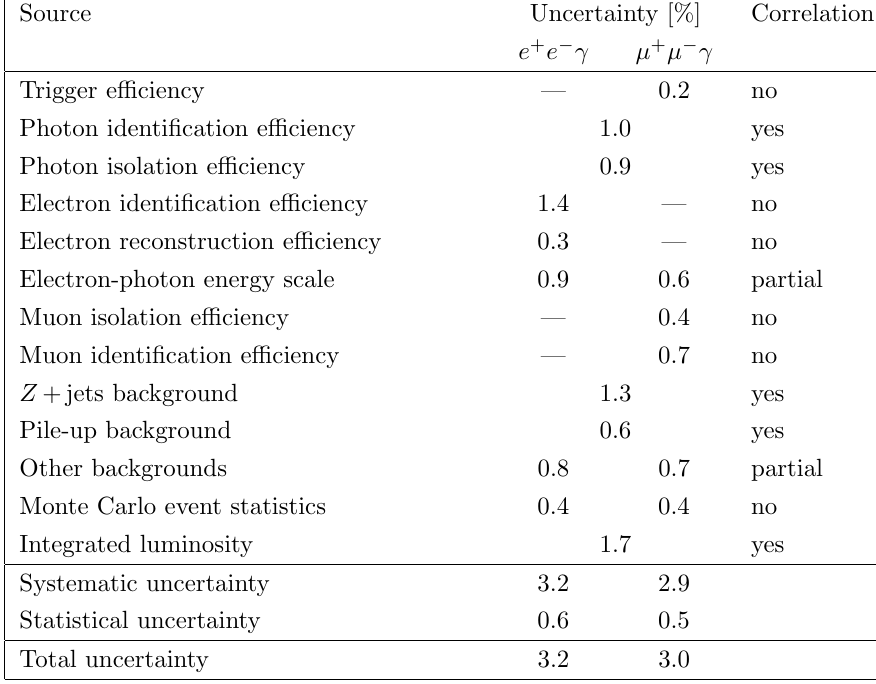
Table 5 . Relative uncertainties in the measured integrated cross-section, (cid:27) (cid:12)d , for ‘ + ‘ (cid:0) (cid:13) production within the (cid:12)ducial phase-space region de(cid:12)ned in table 4. The upper section of the table lists the individual sources of systematic uncertainty, followed by the total systematic uncertainty obtained by combining the individual contributions in quadrature. Only sources which contribute a relative uncertainty of at least 0.1% are listed. An entry \|" indicates that the uncertainty source is not applicable to the given channel or the relative uncertainty is less than 0.1%. The rightmost column indicates whether the uncertainties for each source are fully correlated (‘yes’), partially correlated (‘partial’) or uncorrelated (‘no’) between the e + e (cid:0) (cid:13) and (cid:22) + (cid:22) (cid:0) (cid:13) channels. The penultimate row gives the statistical uncertainty due to the number of observed events in the signal region. The bot- tom row gives the overall relative uncertainty obtained by combining the systematic and statistical uncertainties in